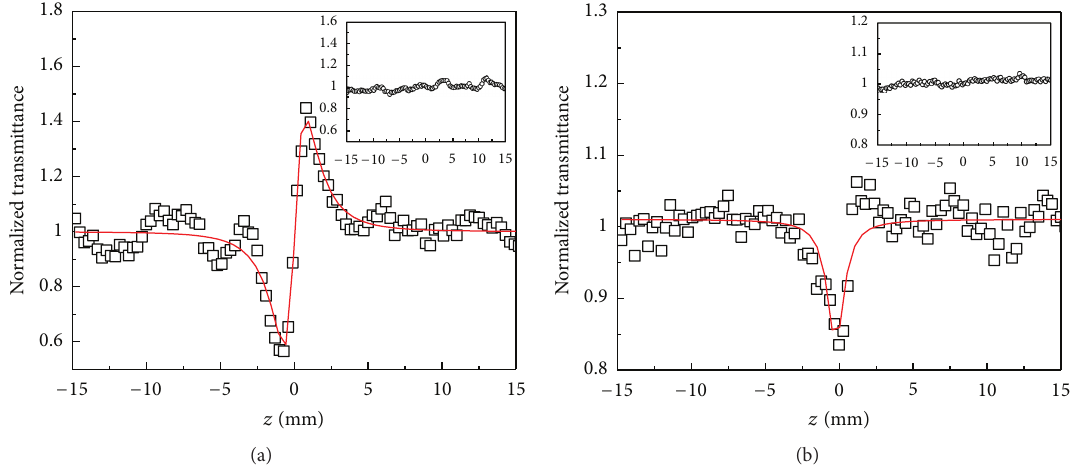
Figure 23: Z-Scan traces of the film with gold NPs at 532 nm (open squares). (a) Nonlinear refraction; (b) nonlinear absorption. The results for the film without gold (open circles) are shown in the insets. Laser intensity: 560 MW/cm 2